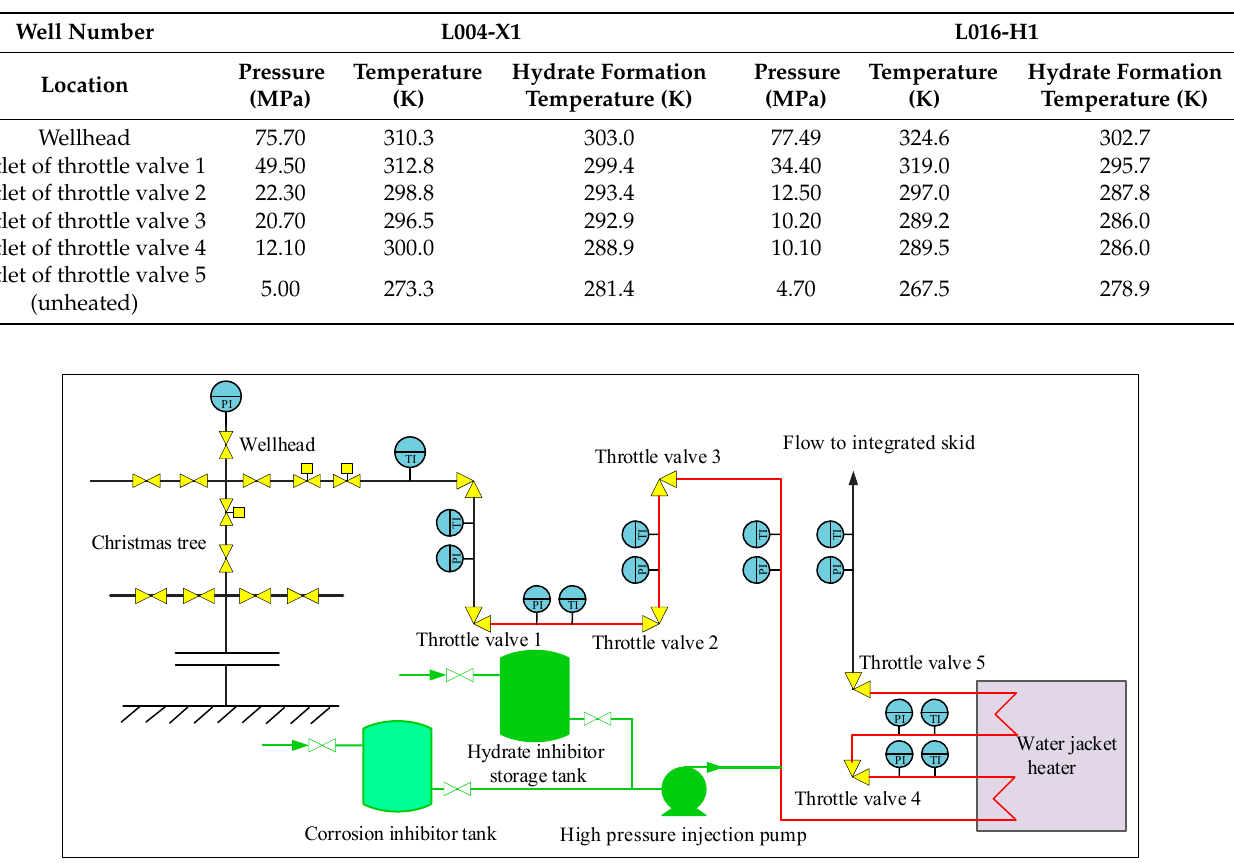
Table 7. Throttling process operation parameters and the hydrate formation temperature of wells L004-X1 and L016-H1 during the trial production period.